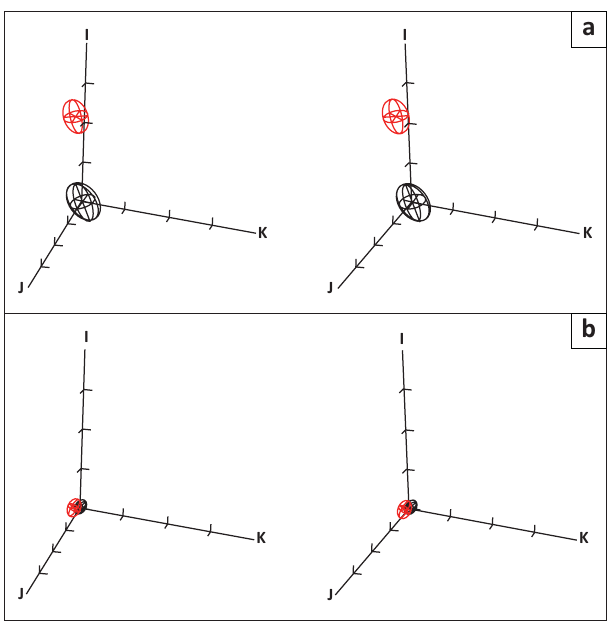
FIGURE 2: Stereo-pair scatter plots for central corneal power with 95 % confidence ellipsoids for a single (a) keratoconic eye and a single (b) control eye. The axis length is 1 D, tick interval is 0.25 D and the origin is placed at the mean of the sample concerned. There were two measurement sessions for each participant in the study. Black represents Session one and red Session two. (Points are omitted to allow greater clarity with the small ellipsoids.) The intersection of confidence ellipsoids (or lack thereof) provides an indication of a change in the means over two measurement